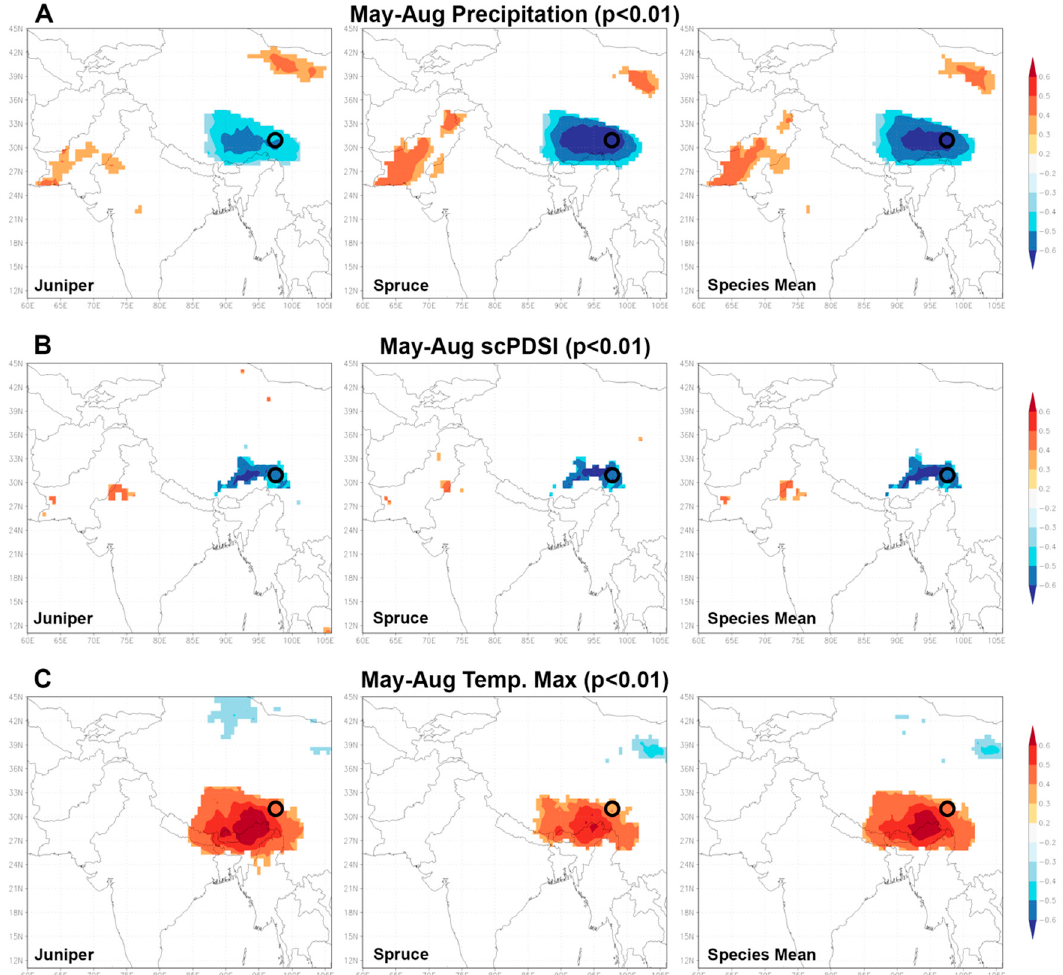
Figure 7. Spatial correlations (p < 0.01) of δ 18 O variations in juniper, spruce and the species’ mean (vertically arranged) with climate variables using the Climate Explorer. ( A – C ) Selected climate variables for the individual species (juniper and spruce) and the calculated δ 18 O mean of our study site for the summer monsoon season (May to August).